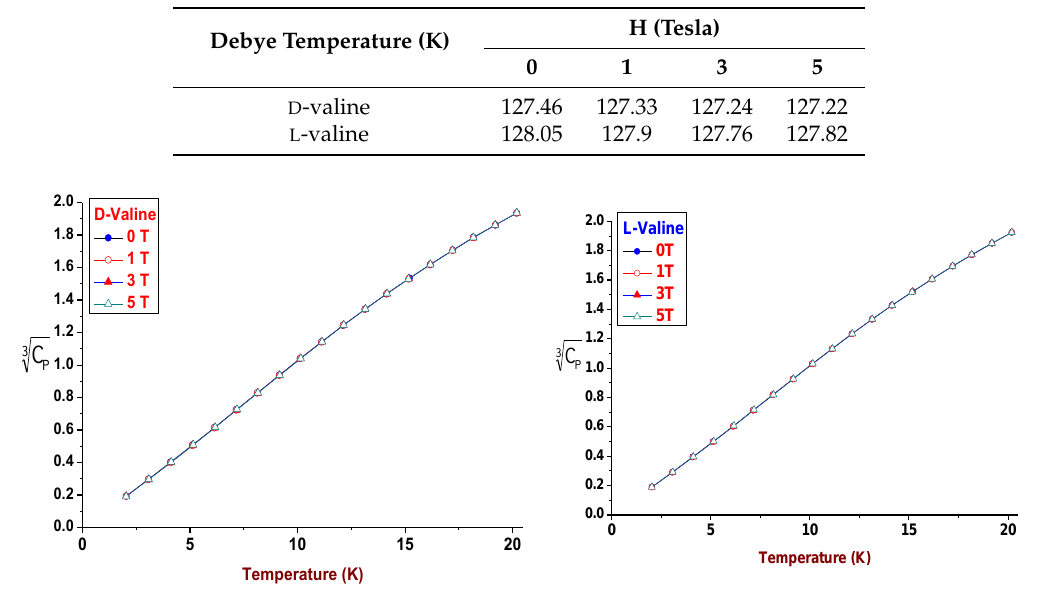
Figure 4. 3 (cid:112) C p versus T of D - and L Figure 4. √ C p 3 versus T of D - and L -valine.